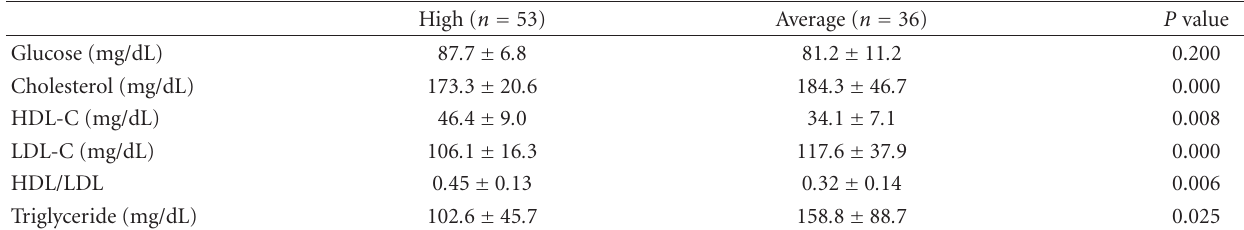
Table 6: Blood glucose and lipid profile for the males in the high and average estimated VO 2